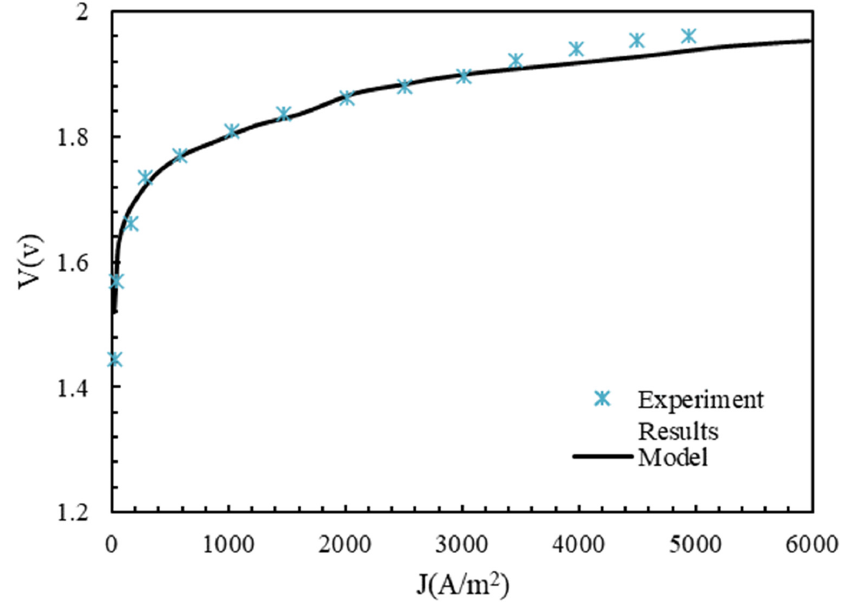
Figure 2. Comparison between experimental results of [43] and modeling results of this article. Table 3. Electrolyzer working conditions for validation.